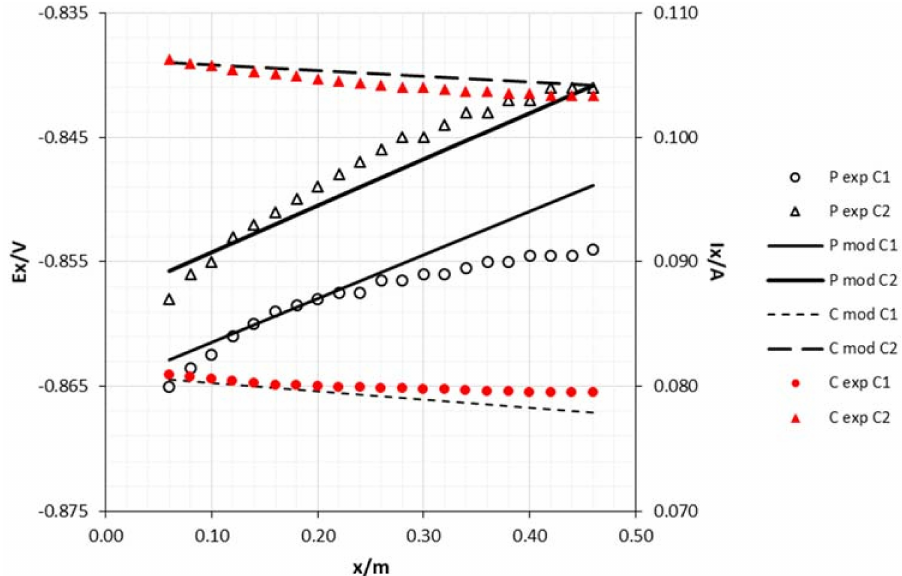
Figure 7. Experimental and model attenuation curves as a function of cathode area (sacrificial anode area: 0.0054 m 2 and edge draining point). Legend: P—potential; C—current; exp—experimental; mod—model; C1—cathode diameter 8 mm; C2—cathode diameter 15 mm.